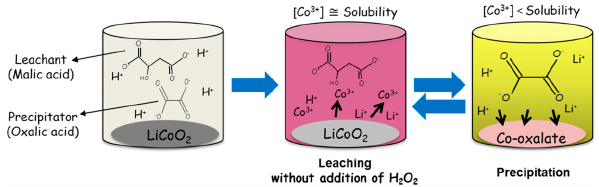
Figure 2. A schematic view of the one-pot process used to obtain cobalt species in the form of Co-oxalate from spent Li batteries using malic acid and oxalic acid. Metals 2017 , 7 , x FOR PEER REVIEW